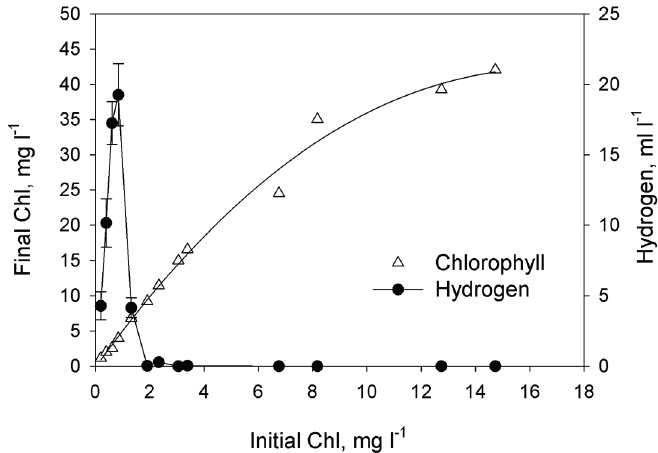
Figure 2. The effect of the initial culture density (measured as the total Chl concentration at the beginning of phosphorus deprivation) on accumulation of the biomass (measured as the final Chl concentration) and the total yield of H 2 gas produced by the culture. The phosphorus deprivation effect was achieved by using the dilution method. Each point represents the average of three independent repetitions. Curve that represents Chlorophyll was drown as nonlinear regression, modified Hyperbola III. For Hydrogen graph was used simple error bars